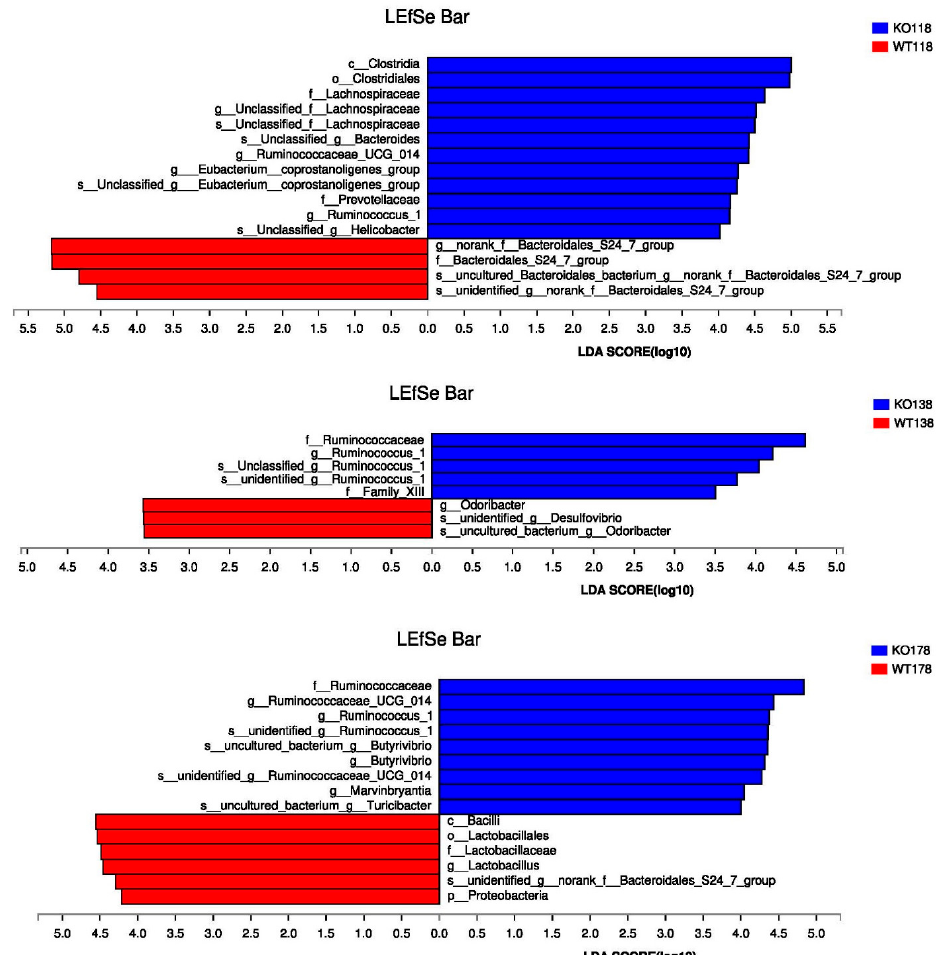
Figure 9. Linear discriminant analysis (LDA) coupled with effect size measurement (LEfSe) analysis of gut microbes among Muc2 − / − and Muc2 +/+ mice. ( A ) Histogram of the linear discriminant analysis (LDA) scores for differentially abundant genera among Muc2 − / − and Muc2 +/+ mice; ( B ) the LEfSe analysis at different time points. WT, Muc2 +/+ mice; KO, Muc2 − / − mice. Interestingly, Roseburia, Butyricimonas, Coprococcus, Clostridium, Ruminococcus , and Eubacterium detected in this study are, in fact, butyrate-producing bacteria in the gut. As shown in Table 1, the total abundances of butyrate-producing bacteria were significantly higher in Muc2 − / − mice than those